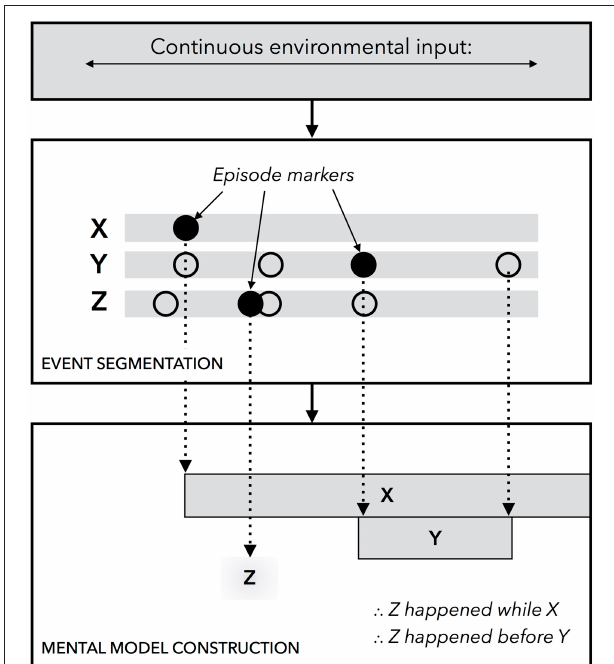
FIGURE 1 | A diagram of the unified theory of event segmentation and representation. In the event segmentation component of the system, which operates online and in parallel with other cognitive processes, changes are detected in continuous environmental input across a finite set of perceptual stimuli, marked by X, Y, and Z in the diagram. At the onset of a stimulus, which is indicated by a black circle, a new episodic marker is constructed. The offset of a stimulus likewise yields a new episodic marker. When the system is queried for information pertaining to temporal relationships, it uses the markers to build a discrete event model. The system then scans the model to make